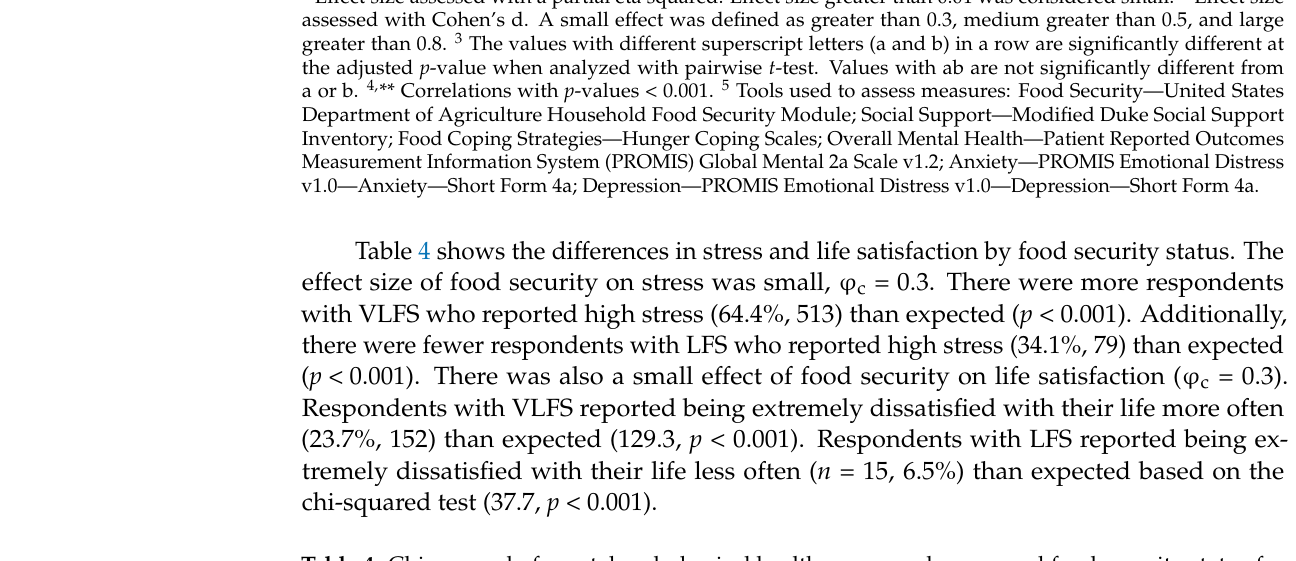
Table 4. Chi-squared of mental and physical health measures by race and food security status for food-insecure mothers in Virginia ( n =